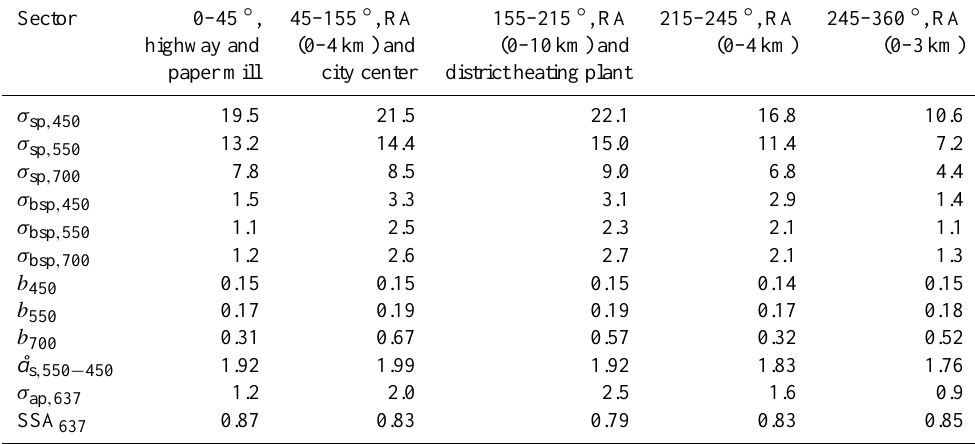
Table 2. The averages of the aerosol optical parameters over the chosen sectors with emission sources: highway, paper mill, city center, district heating plant, and residential areas (RA) extending up to 10km. Please see caption of Table 1 for explanation of the parameters.